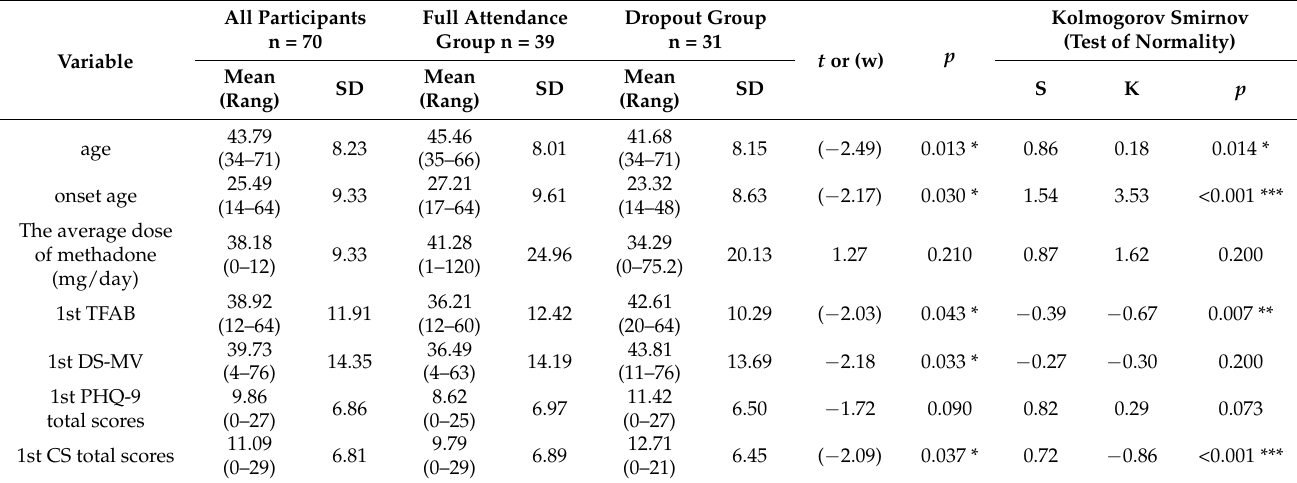
Table 2. Pretest in the intervention group and dropout